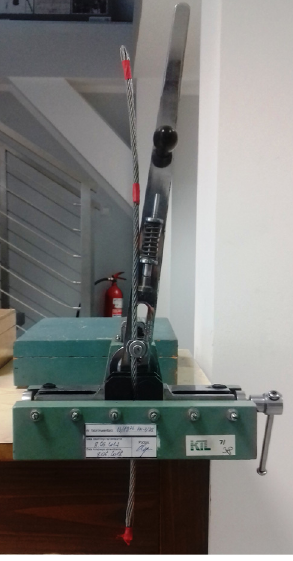
Figure 1: Equipment for bending steel wire rope.